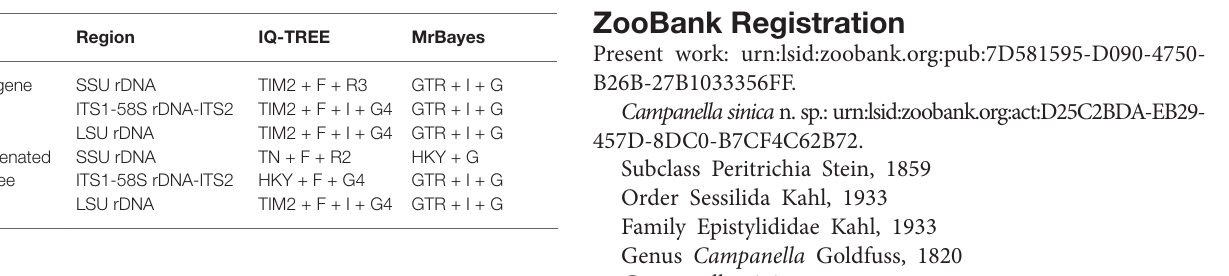
The ends of alignments were refined by eye. The final comparisons were edited and viewed by Bioedit v.7 (Hall, 1999) and TBtools (Chen et al., 2020a). The nucleotide differences between each of the new sequences and those species with high sequence